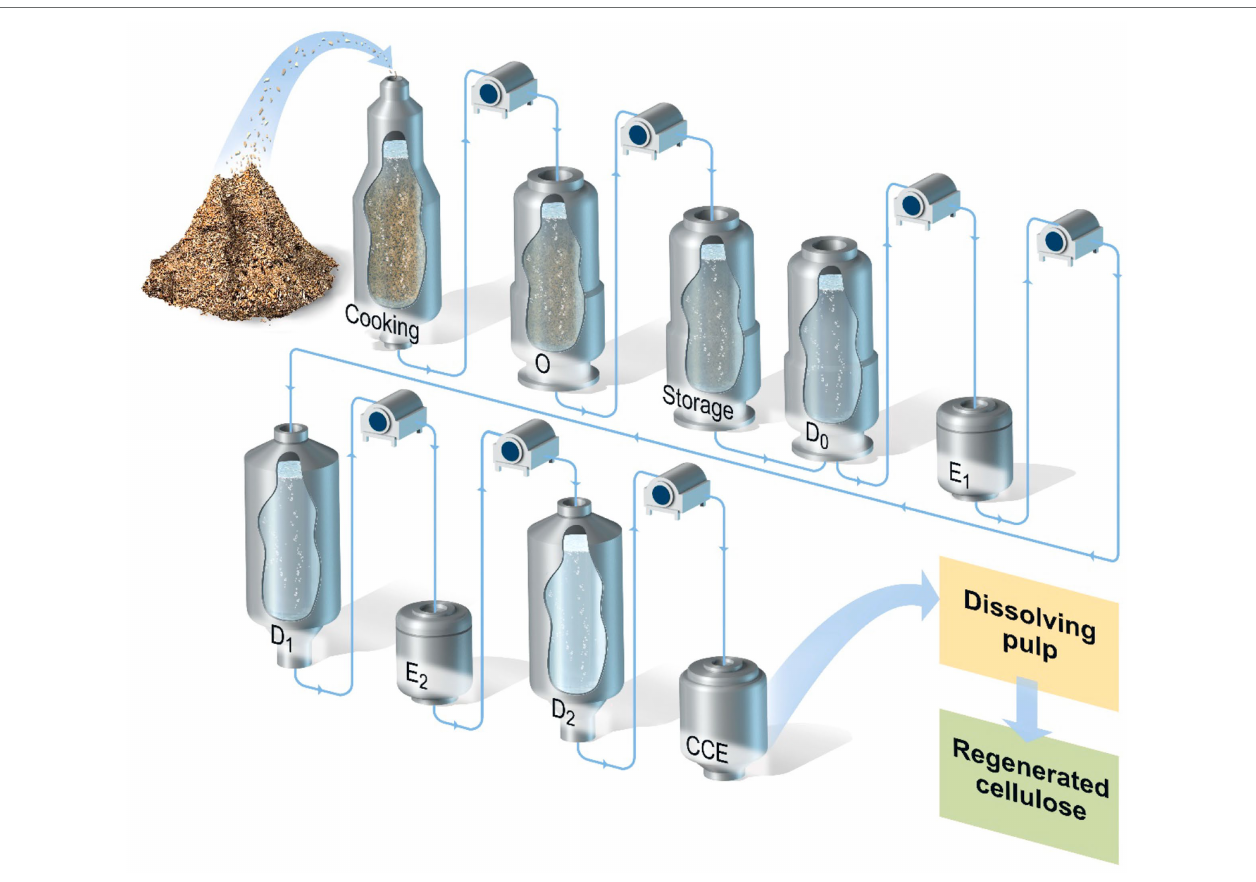
FIGURE 1 | Processing of wood chips for the production of kraft dissolving pulp. The process includes the following stages after the cooking: oxygen delignification (O); storage for xylanase pre-treatment; chlorine dioxide delignification (D 0 ); alkaline extraction stage 1 (E 1 ); chlorine dioxide bleaching stage 1 (D 1 ); alkaline extraction stage 2 (E 2 ); chlorine dioxide bleaching stage 2 (D 2 ); and cold caustic extraction